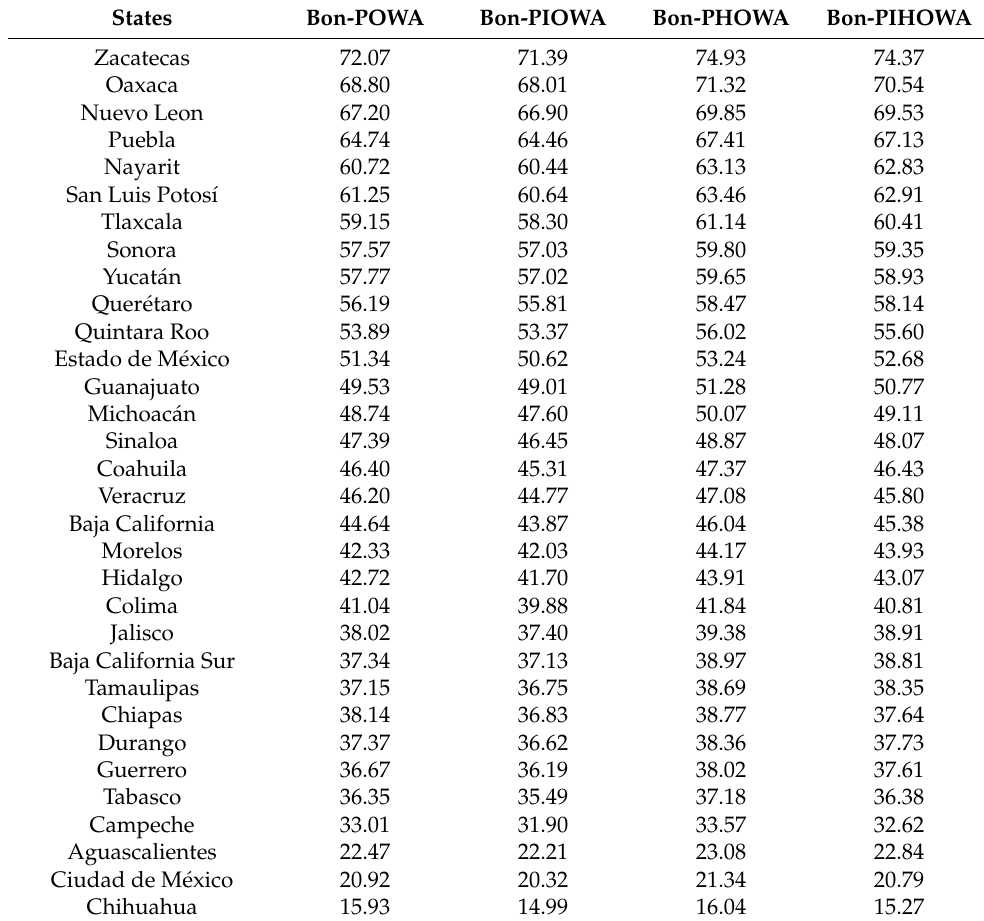
Table A6. Results of prioritized Bonferroni